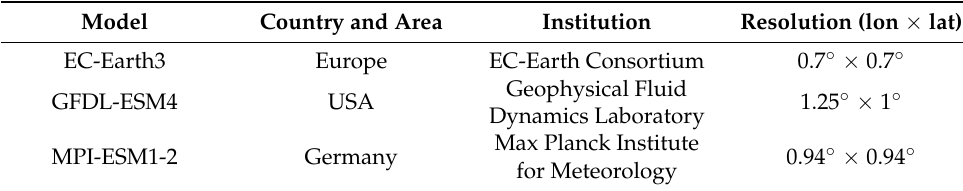
Table 2. Information of the CMIP6 models used in this study. Model Country and